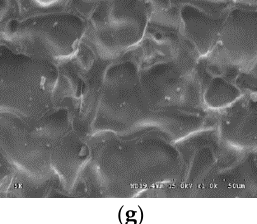
Figure 2. The SEM images of BCTS–yLiF sheets (y = 0 and y = 0.07). ( a ) 1420 °C, y = 0; ( b ) 1450 °C, y = 0; ( c ) 1480 °C, y = 0; ( d ) 1360 °C, y = 0.07; ( e ) 1390 °C, y = 0.07; ( f ) 1420 °C, y = 0.07; ( g ) 1450 °C, y = 0.07.